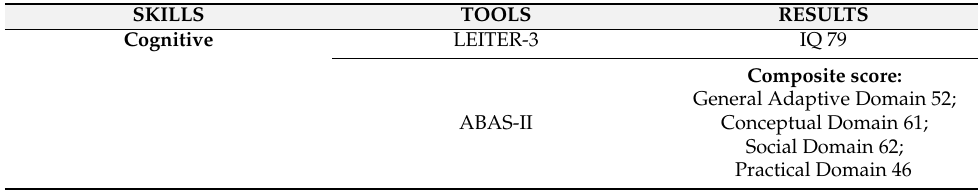
Table A1. Neuropsychiatric